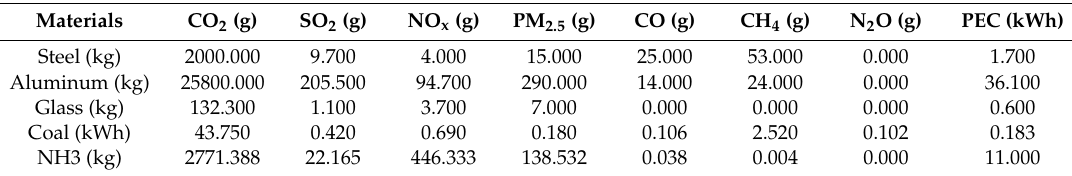
Table 6. The exploitation pollutant emissions and primary energy consumption (PEC) of unit raw materials.